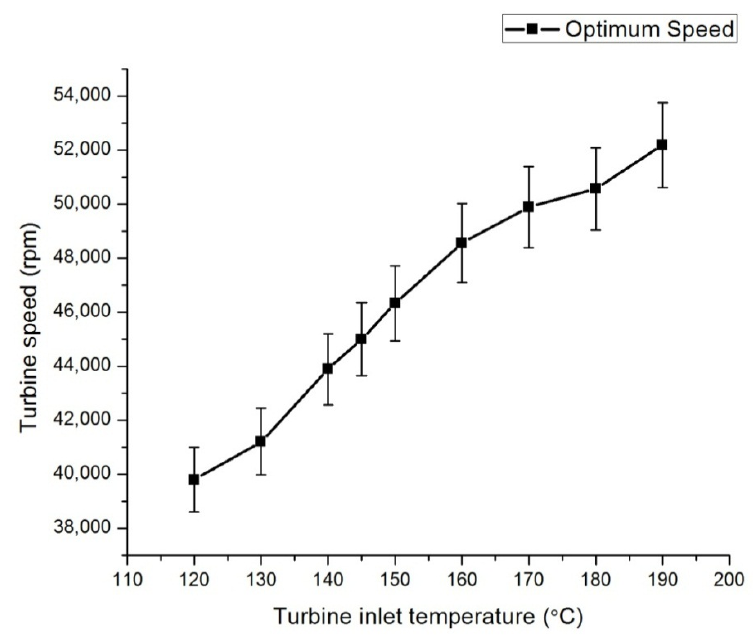
Figure 8. Variation of optimum turbine speed on turbine inlet temperature.